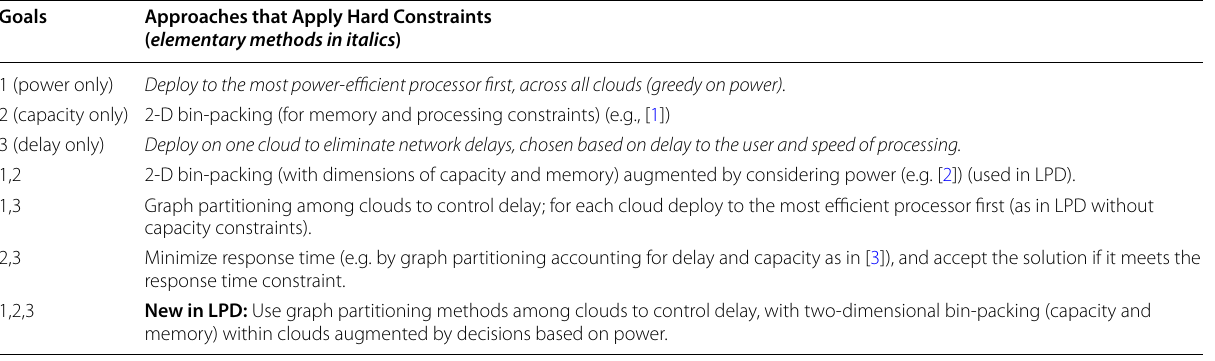
Table 1 Deployment problem cases and scalable solution approaches (excluding metaheuristics and MIP)